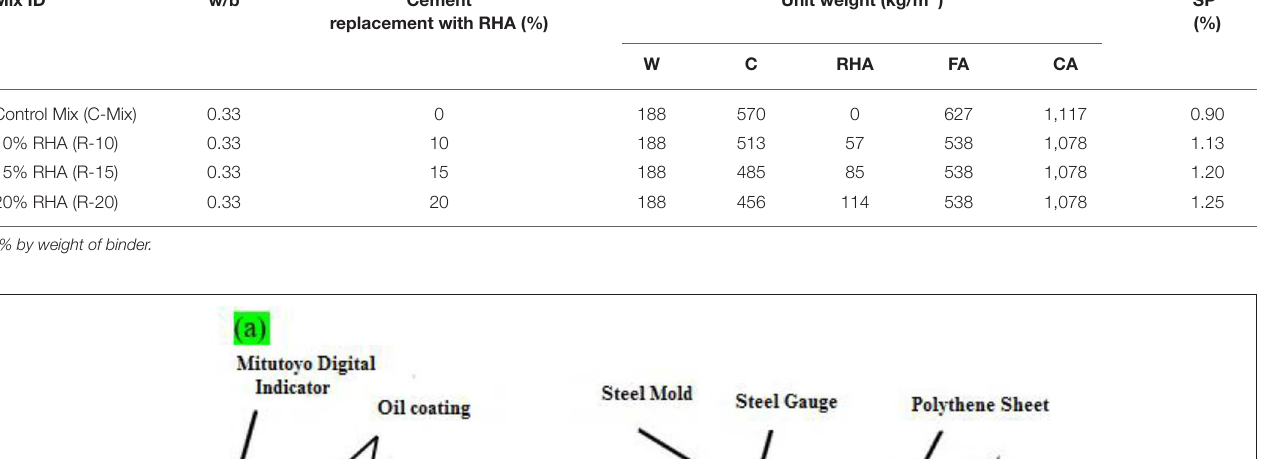
Unit weight (kg/m 3 )